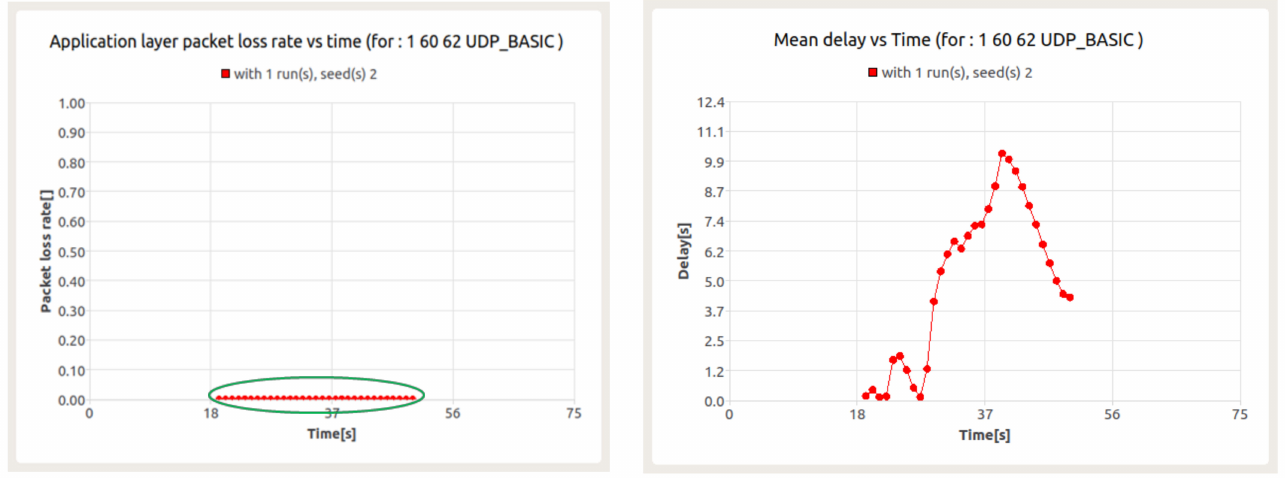
Figure 18. Packet loss ratio ( left ) and e2e delay ( right ) for UDP session in the presence of background traffic—node